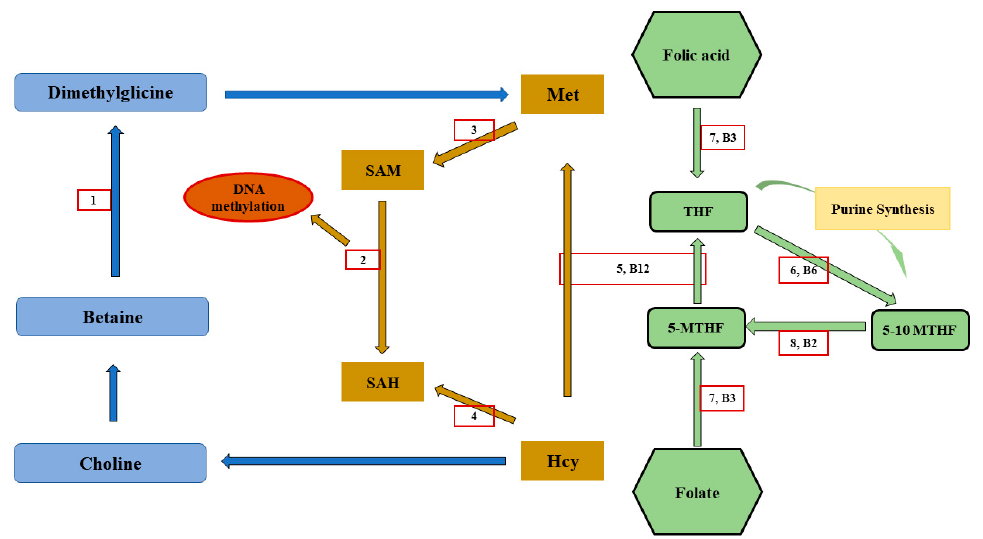
Figure 4. A simplified scheme of ONE carbon metabolism and its implication on DNA methylation. (1: betaine homocysteine methyltransferase (BHMT); 2: DNA methyltransferase (DNMT); 3: methionine adenosyltransferase (MAT); 4: S-adenosyl homocysteine hydrolase (SAHH); 5: methionine synthase (MS); 6: serine hydroxymethyltransferase (SHMT); 7: dihydrofolate reductase (DHFR); 8: methylenetetrahydrofolate reductase (MTHFR); SAH: S-adenosylhomocysteine; SAM, S-adenosylmethionine; THF: tetrahydrofolate; 5-MTHF: 5-methyltetrahydrofolate; and 5,10-MTHF: 5,10-methyltetrahydrofolate.) (adapted from [144]).